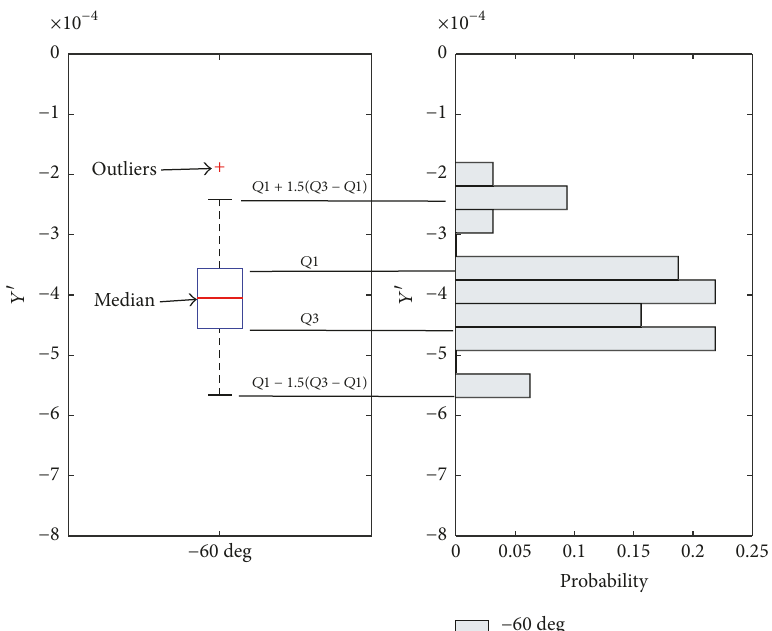
Figure 14: The box plot and the corresponding histogram for the 32 runs of the flat plate with a negative initial angle.